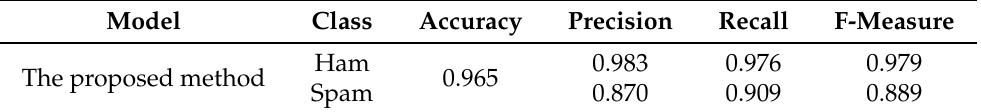
Table 5. Evaluation